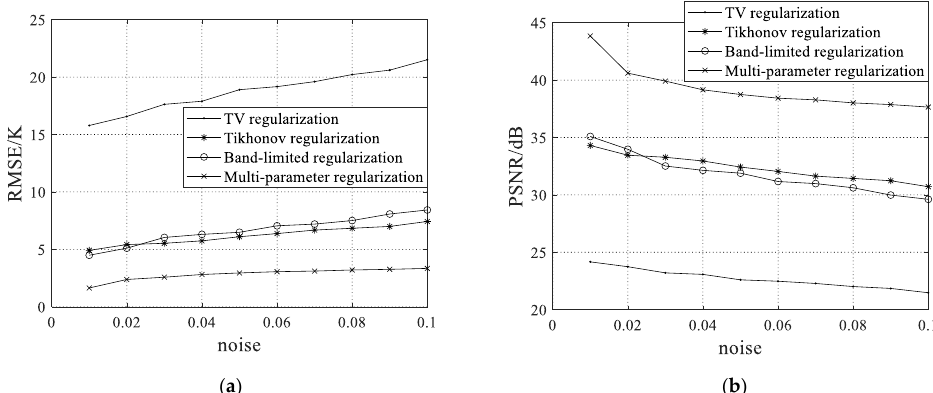
Figure 8. The performance comparison of the regularization approaches for the coast for different noise levels: ( a ) the root mean square error; ( b ) the peak signal to noise ratio.